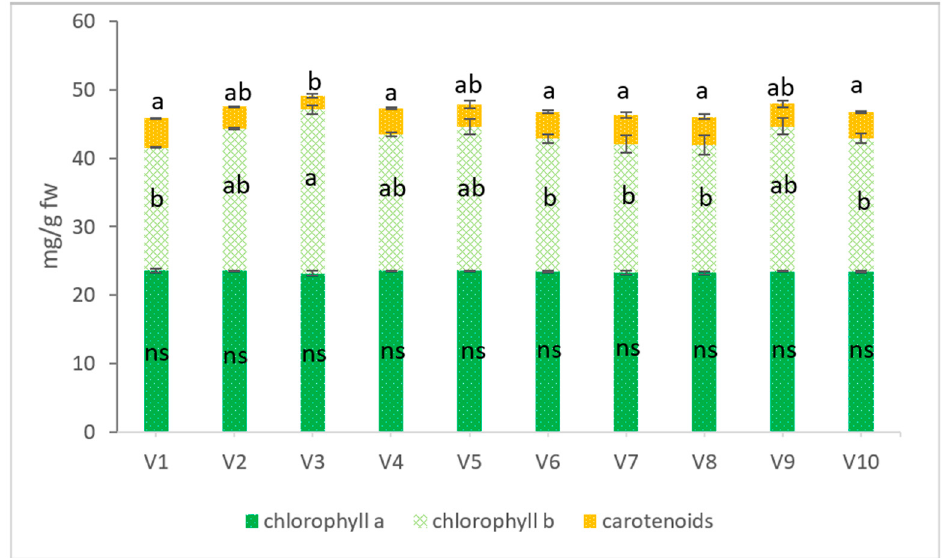
Figure 2. Chlorophyll a, chlorophyll b, and carotenoids in wheatgrass juice. The values represent the mean ± standard error. The lowercase letters represent statistically significant differences according to the Tukey Test, p < 0.05. ns: not significant.